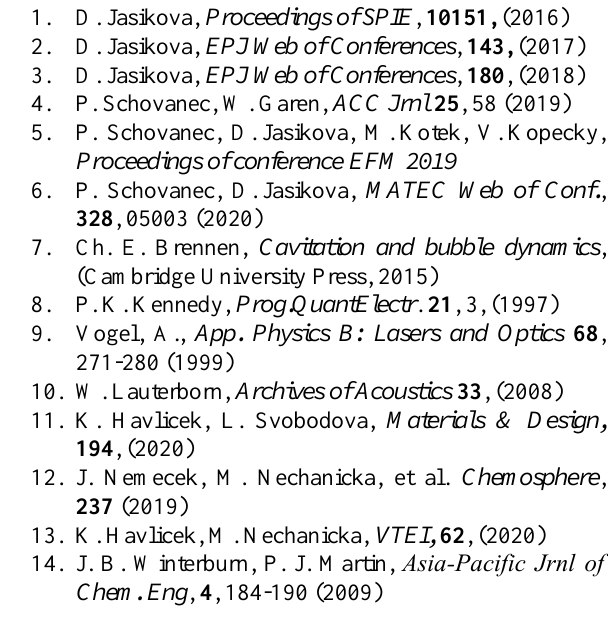
Fig. 8. The evaluation of live/dead bacteria after one minute of